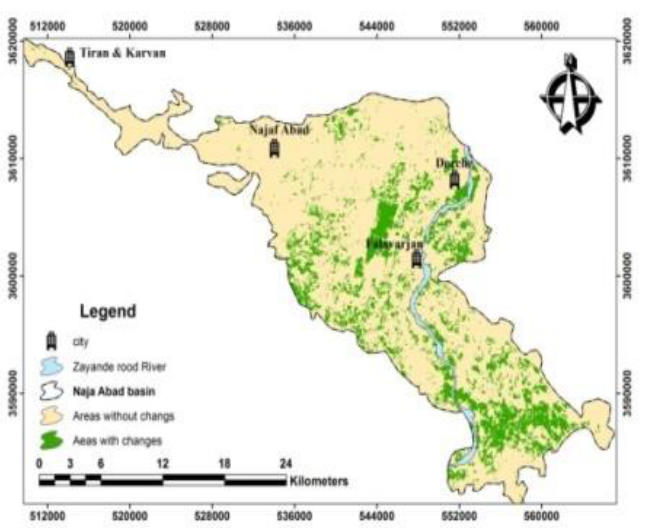
Figure 6. Zoning of unchanged pixels and changes pixel between 2008 to 2015